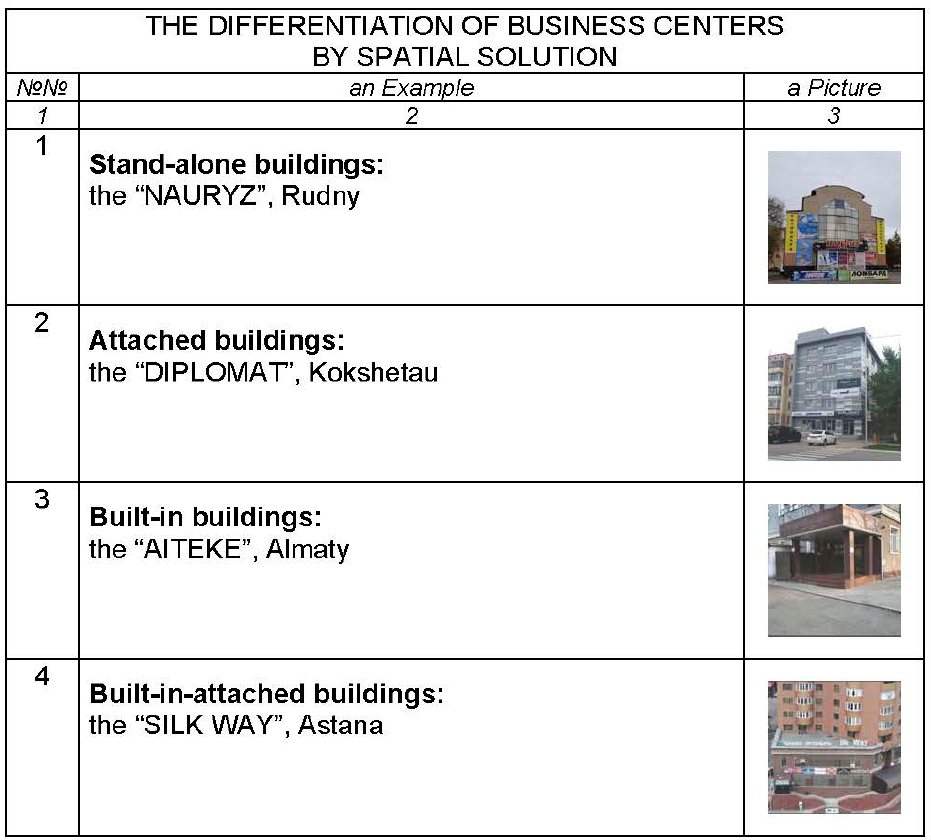
Figure 15. The differentiation of business centers by spatial solution: ( 1 ) the NAURYZ, Rudnyi [128]; ( 2 ) the DIPLOMAT, Kokshetau [129]; ( 3 ) the AITEKE, Almaty [130]; and ( 4 ) the SILK WAY, Astana [131].